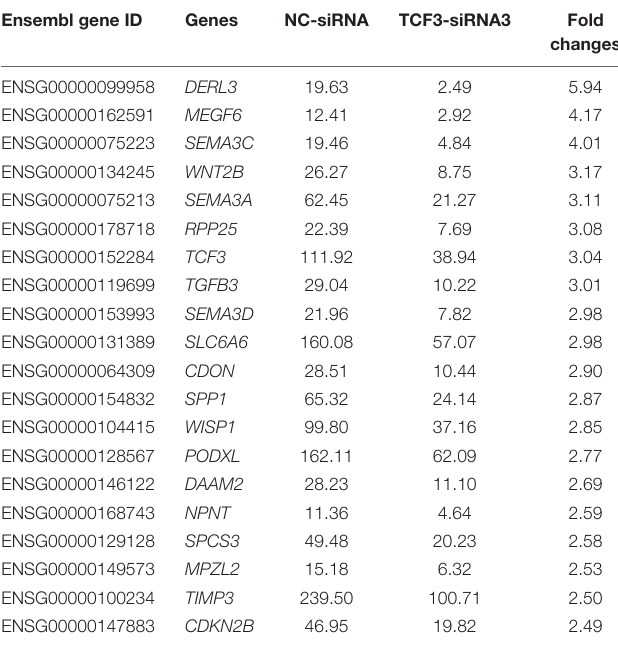
TABLE 1 | Top 20 down-regulated genes by TCF3-siRNA